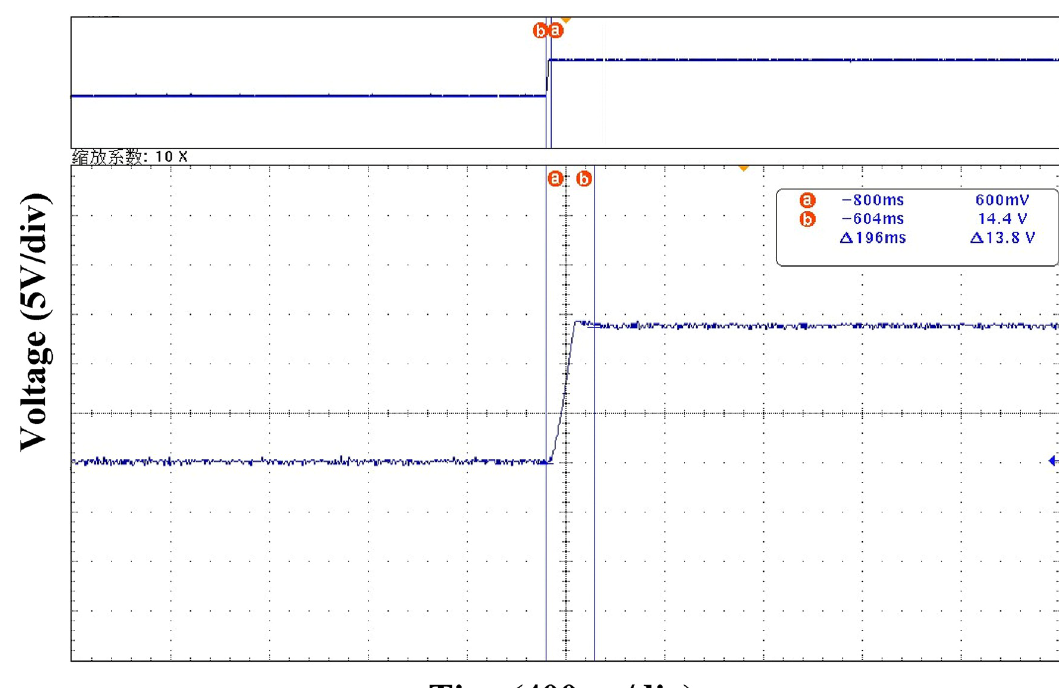
Fig 24. Startup waveform under ATSMC control strategy.